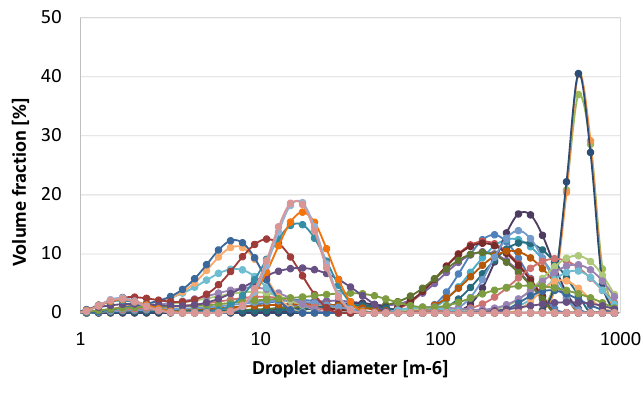
Figure 6. An example of the distribution function (Volume fraction) acquired by Spraytec. The figure shows volume fraction distributions for 27 different measurement. Two significant droplet diameter mods are clearly visible for all of the measurements.